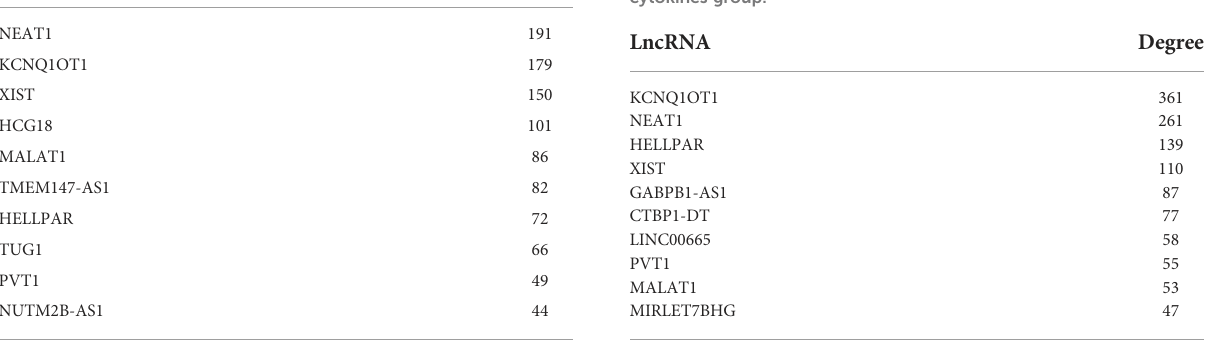
TABLE 2 The top 10 LncRNAs for degree on the network in cytokines